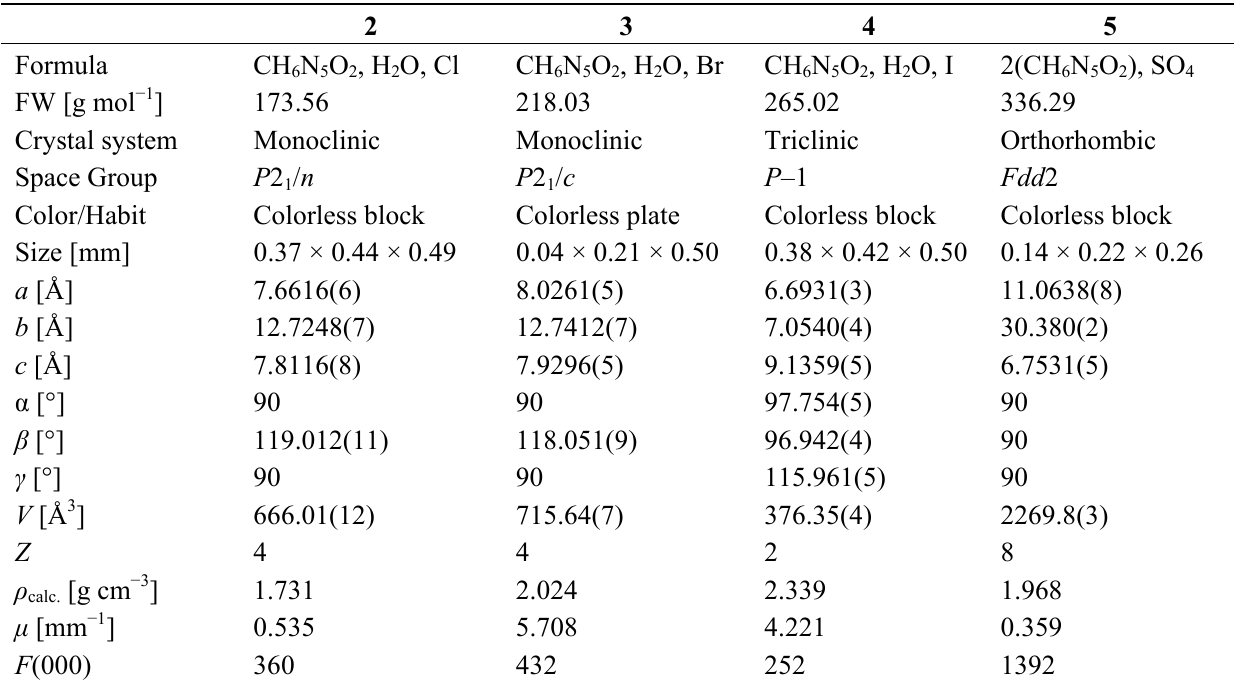
Table 1. X-ray data and parameters of 2 – 5